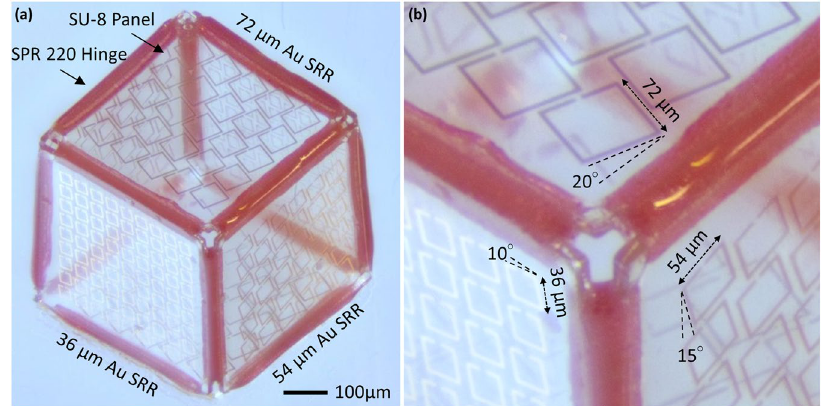
Figure 5. Optical Image of the 500 μ m three-dimensional cubic inclinometer. ( a ) Three-dimensional cubic inclinometer with SU-8 panels, SPR 220 hinges, and Au SRRs of varying lengths with a tilt patterned on the surface. The cube consists of 5 × 5 array of 72 μ m resonators (tilted at 20°), 6 × 6 array of 54 μ m resonators (tilted at 15°), and 9 × 9 array of 36 μ m resonators (tilted at 10°). Resonators on the opposite faces are identical. ( b ) A zoomed-in optical image of the 3D cubic